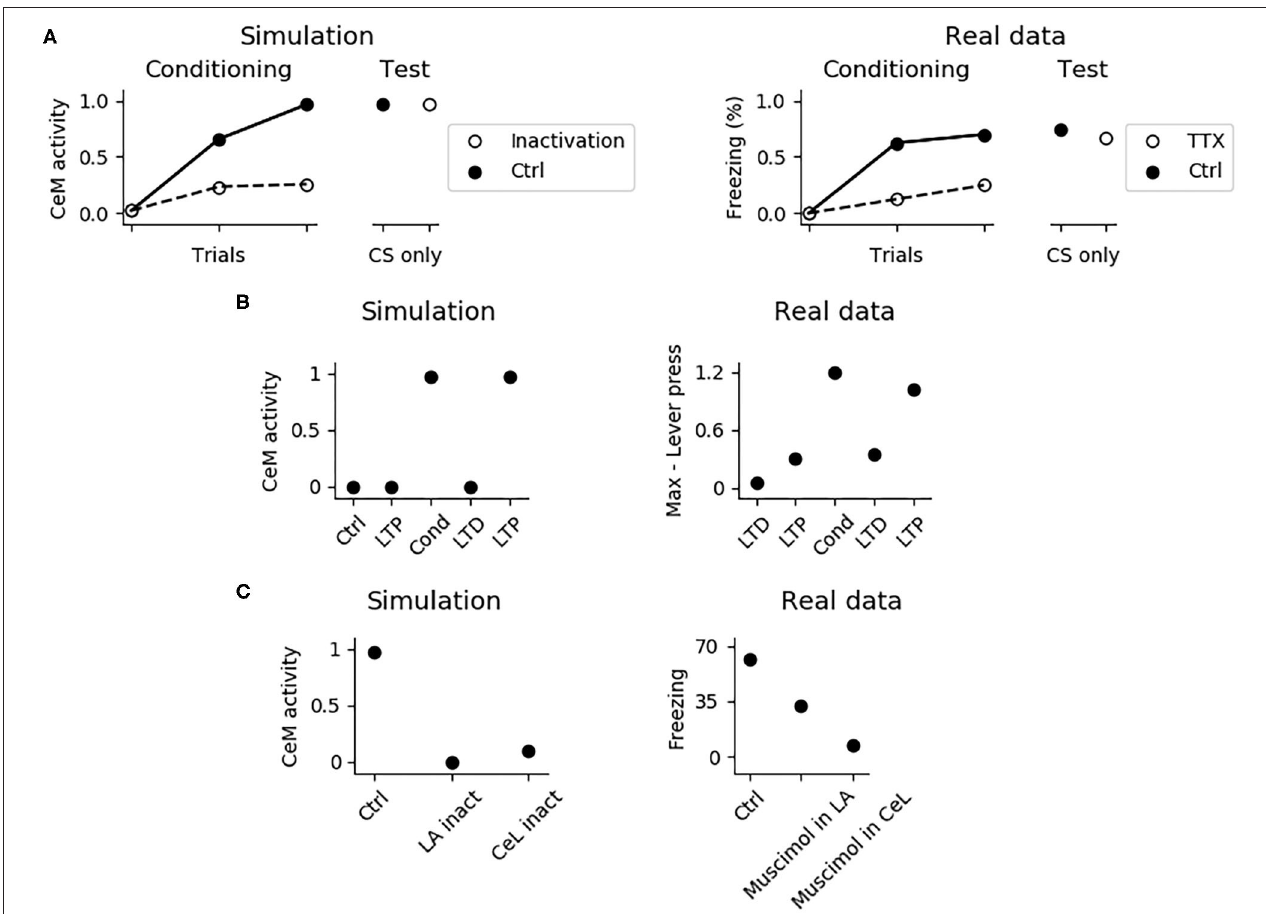
FIGURE 7 | Effects of various manipulations of the model during conditioning. (A) When the PL is inactivated, mimicking the action of TTX, CeM activation is impaired during the CS delivery in the three trials of fear conditioning; this manipulation does not affect fear conditioning, as shown in a successive test phase, where the PL is restored. The simulation correctly reproduces real data reconstructed from Corcoran and Quirk (2007). (B) CeM activity after the CS delivery in the control model (Ctrl), in the model where the CS-pathway to LA was potentiated (LTP), conditioned (Cond), depotentiated (LTD), and repotentiated (LTP). The simulation mimics the findings of Nabavi et al. (2014). (C) If LA (La inact) or CeL (CeL inact) are inactivated during conditioning, in the successive test phase the CS fails to activate CeM. Real data reconstructed from Wilensky et al. (2006) showing that the GABAa agonist muscimol, injected to inactivate LA or CeL during training, strongly impairs fear conditioning in the test